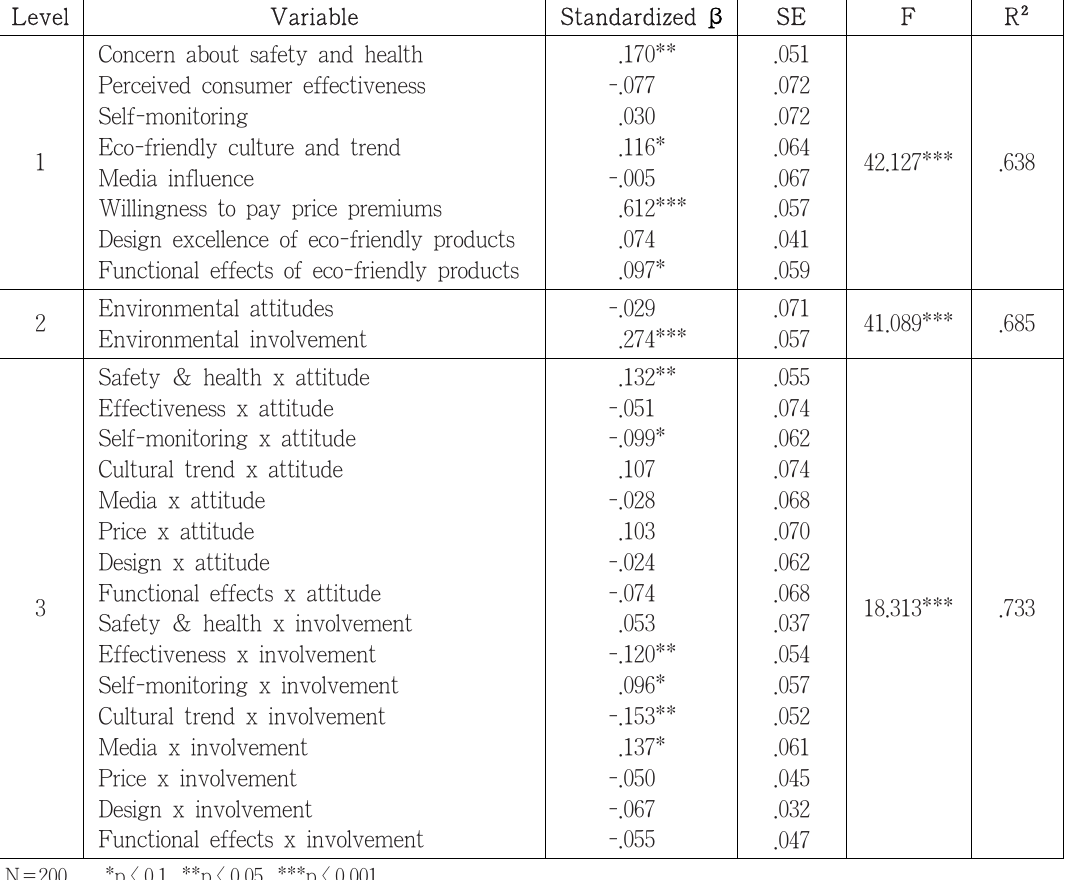
<Table 4> Regression analysis results of eco-friendly buying